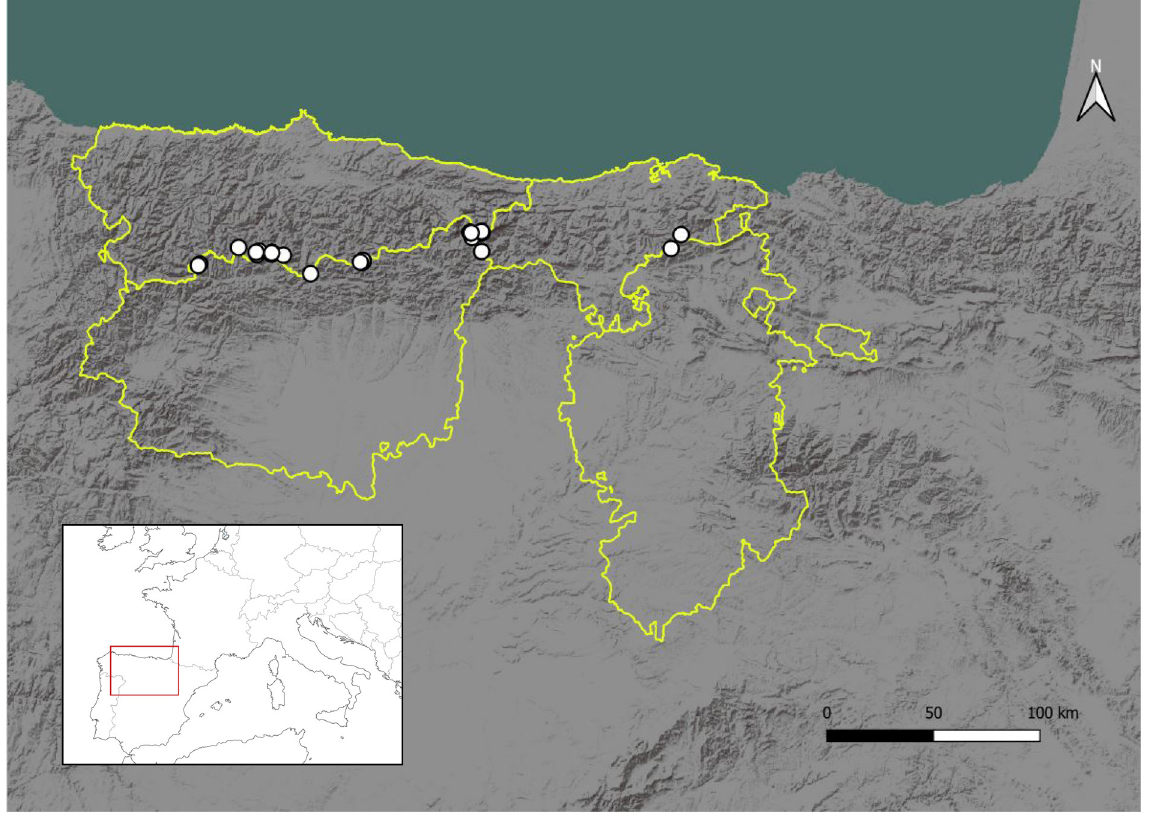
Fig. 10. Map of central northern Spain depicting the geographic distribution range of Pseudochelidura cantabrica Cuesta-Segura, Jurado-Angulo & García-París sp. nov. The inset map of part of western Europe indicates the area included in the larger map. Yellow lines identify regional or provincial limits that include records of the species. White dots correspond to the species records (see text sections of type series, material examined and previous records of P. cantabrica for precise